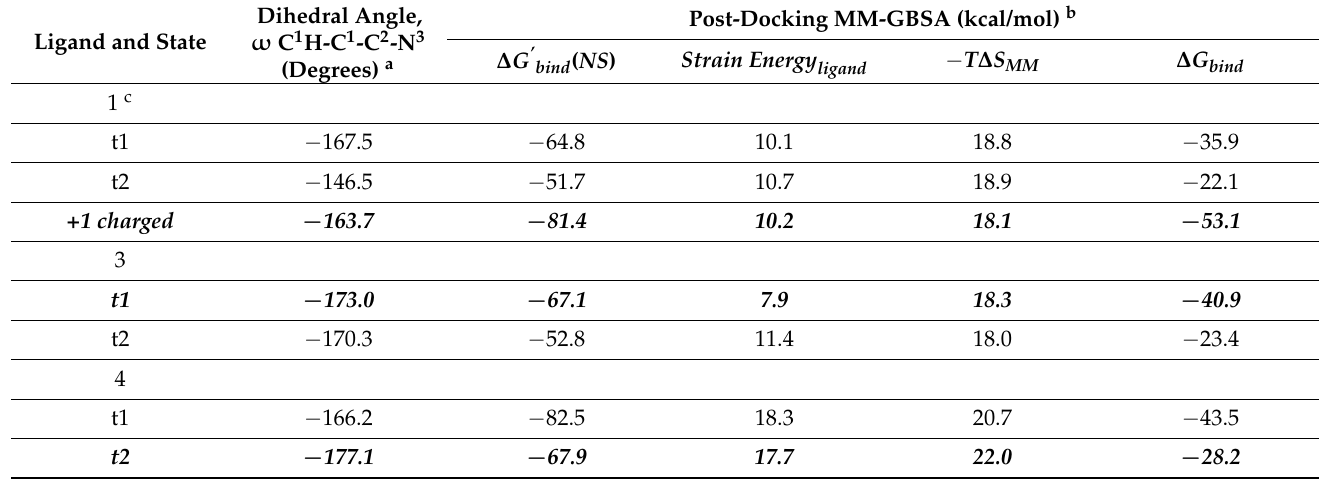
Table 3. Results of MM-GBSA post-docking calculations with the predicted binding tautomer/state highlighted in bold italics .